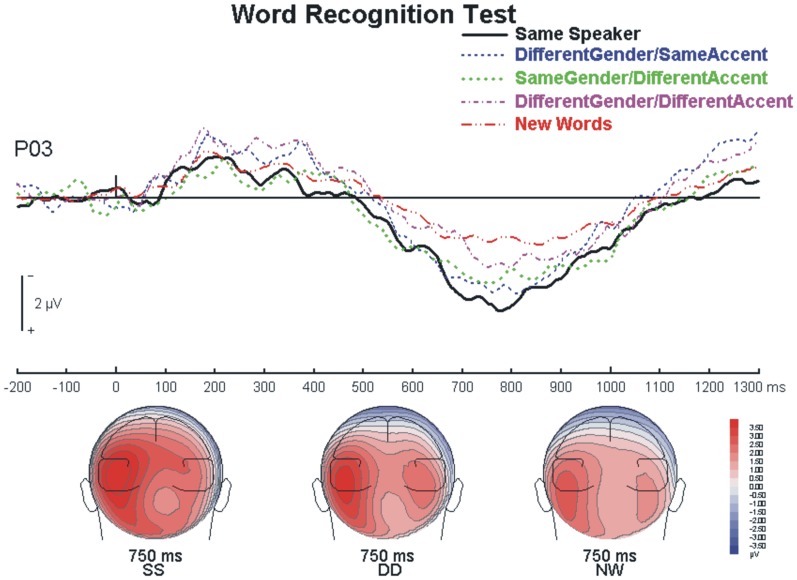
Left Parietal Old/New Effect.Recorded over the left parieto-occipital site (i.e., PO3) during the Word Recognition Test, showing all five conditions. SS  =  same speaker; DD  =  different gender/different accent; NW  =  new word.